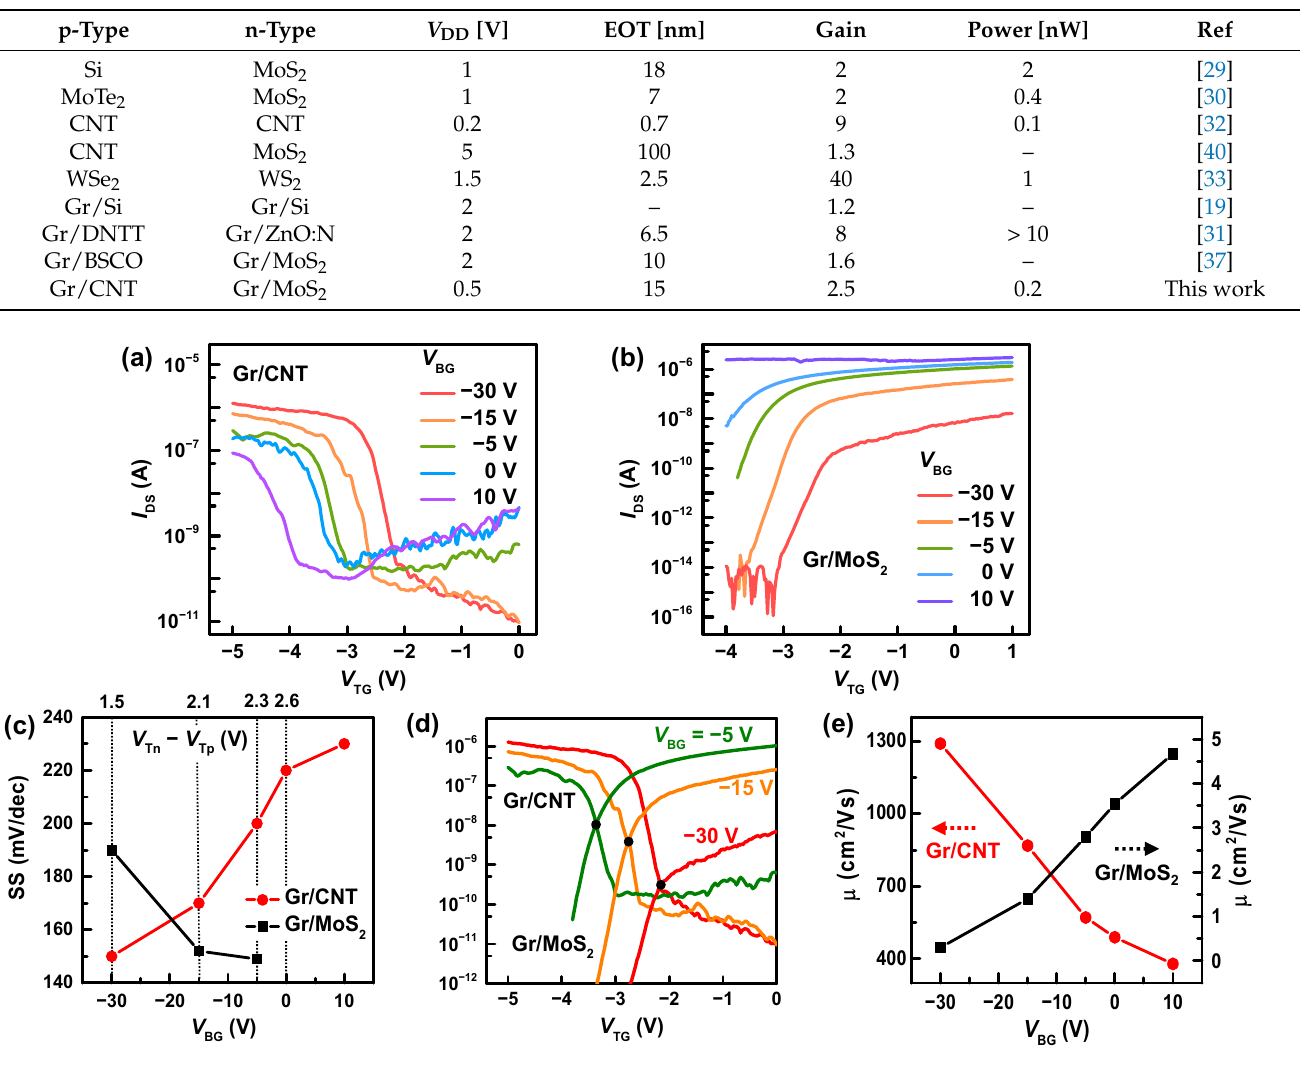
Figure 4. ( a ) Drain-source current, I DS , versus V TG of the Gr/CNT barristor, obtained from various V BG . A reverse drain-source bias, V DS , of –0.5 V is applied to the CNT so that holes cross the Schottky barrier from graphene to CNT. ( b ) Transfer curves of the Gr/MoS 2 barristor, measured at different V BG . V DS = 0.5 V is applied to the MoS 2 , allowing electrons to cross the Schottky barrier from graphene to MoS 2 . ( c ) Subthreshold swing of the Gr/CNT and Gr/MoS 2 barristors, deduced from transfer curves for different V BG . ( d ) Transfer curves of the Gr/CNT and the Gr/MoS 2 barristors displayed together for selected V BG . The intersection of the transfer curves occurred at a lower current regime with decreasing V BG . ( e ) Estimated field-effect mobility as a function of V BG . See the left axis for the Gr/CNT barristor and the right axis for the Gr/MoS 2